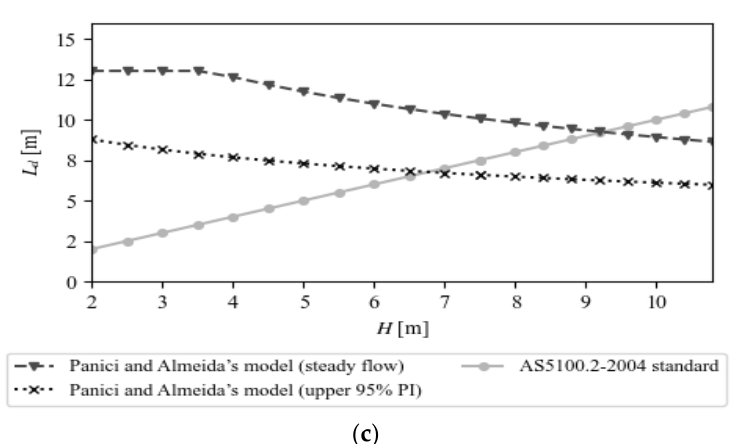
Figure 7. Relationship between ( a ) the width, ( b ) the height, ( c ) the length of debris accumulation and the water height (H) for the two different debris modelling approaches. The results are represented for the steady flow condition and for the upper prediction bound of the regression curve of Figure 3.